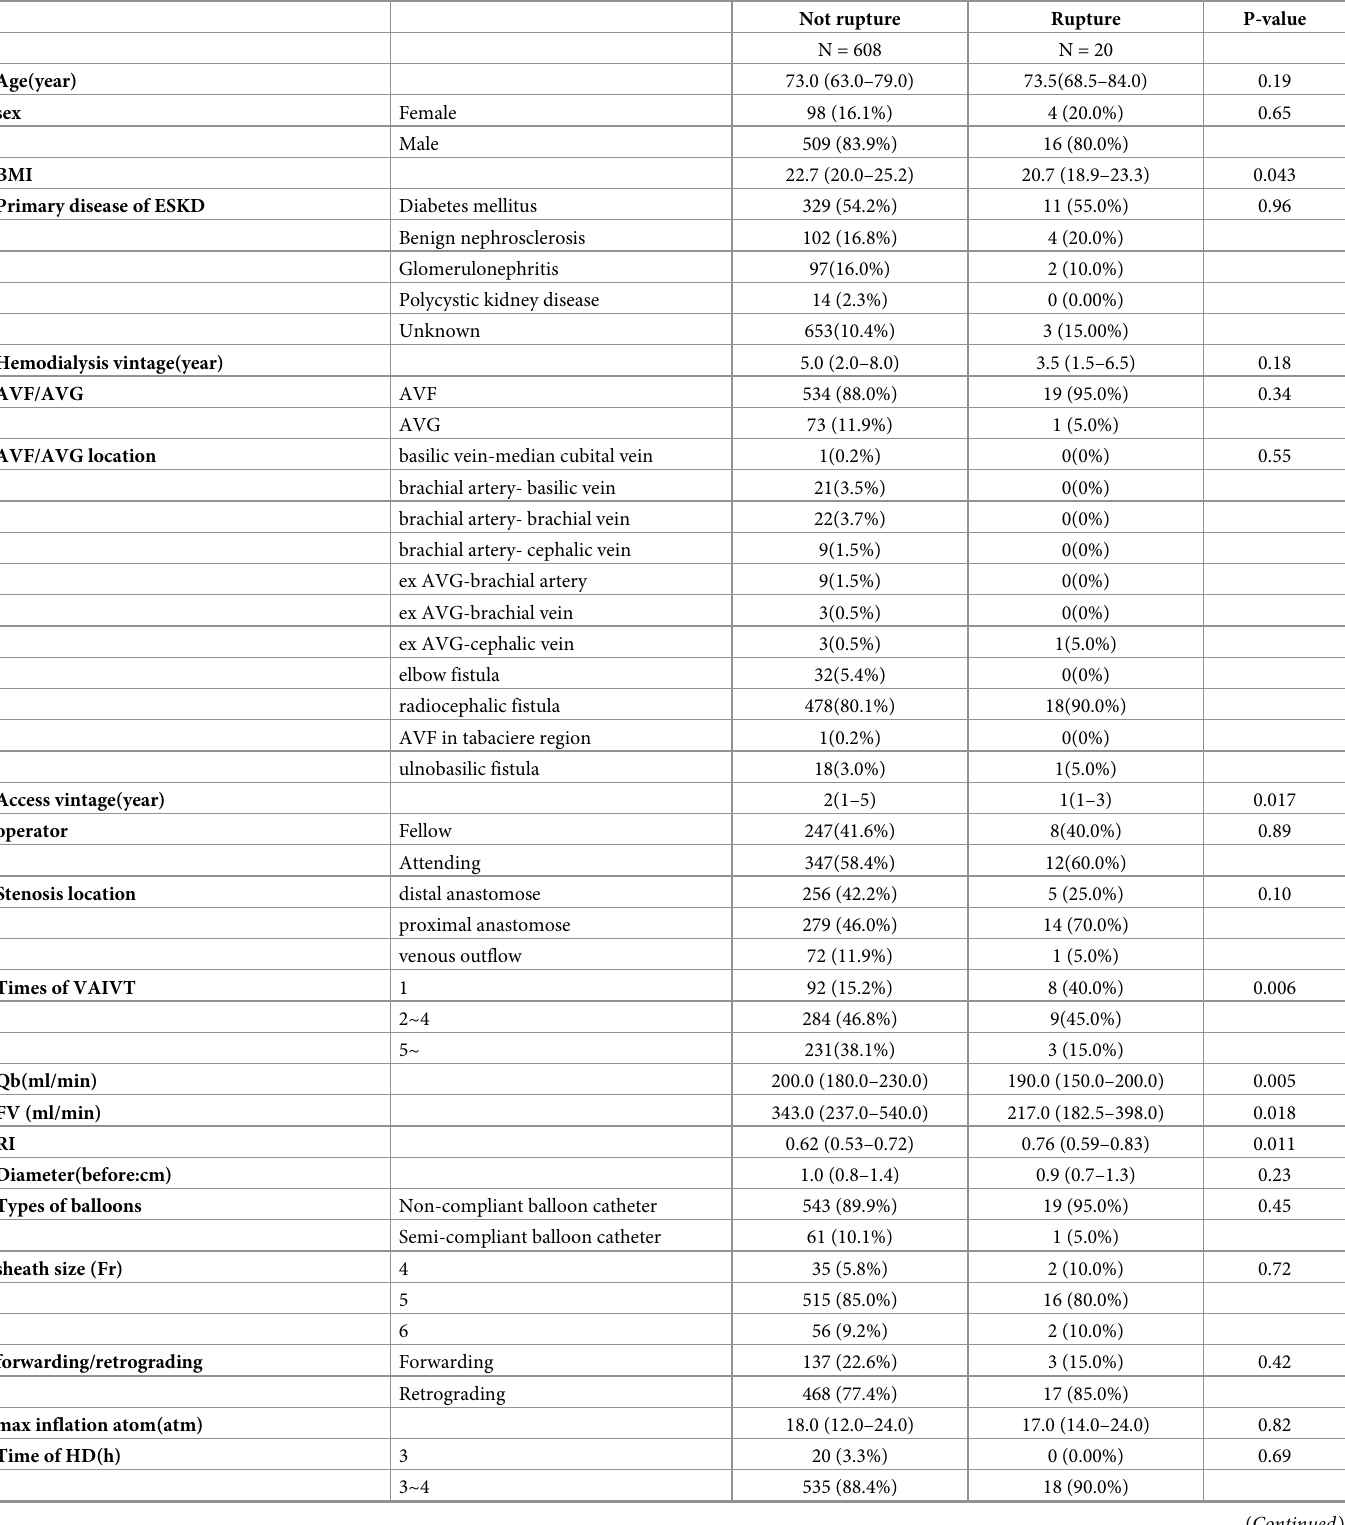
Table 1. Baseline clinical and biochemical characteristics of 628 patients receiving vascular access intervention therapy. (Wilcoxon-test or chi-square